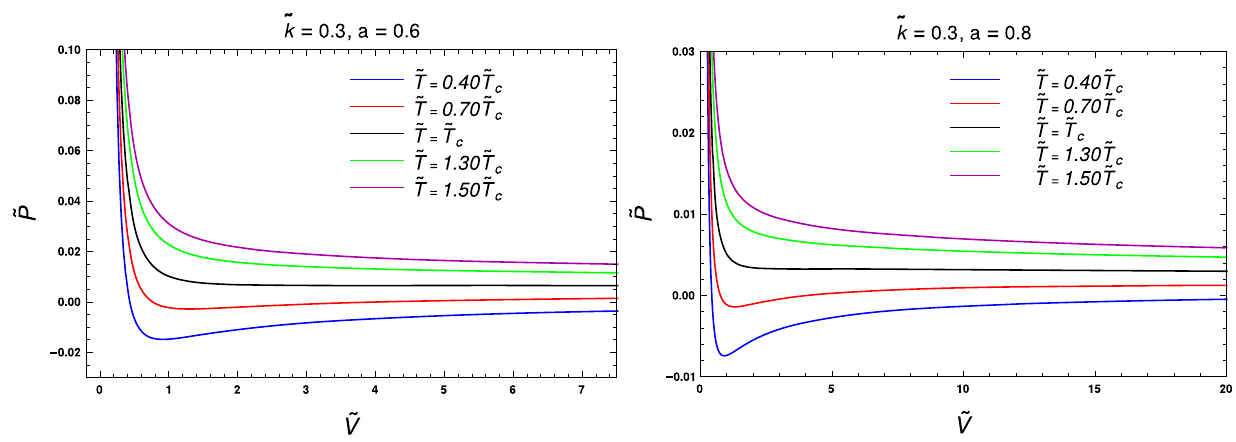
Fig. 9 The isotherms of black holes in ˜ P - ˜ V plane for two different values of parameter a = 0 . 6 where ˜ T c = 0 . 0340578 (left) and a = 0 . 8 where ˜ T = 0 . 0170289 (right) with fixed ˜ k = 0 . 3. The temperature of isotherms decreases from top to c